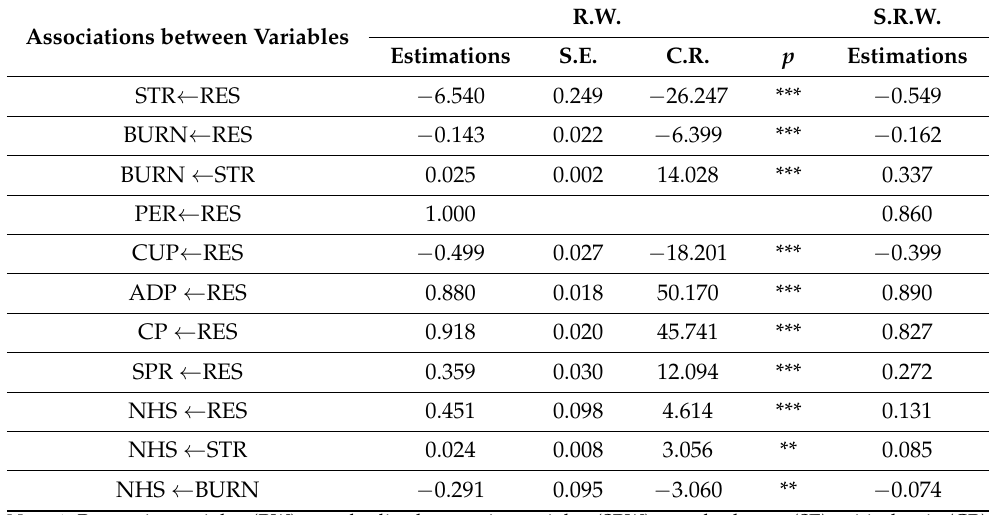
Table 2. Values obtained from the proposed structural equation model for participants doing more than 3 h of physical activity per week.